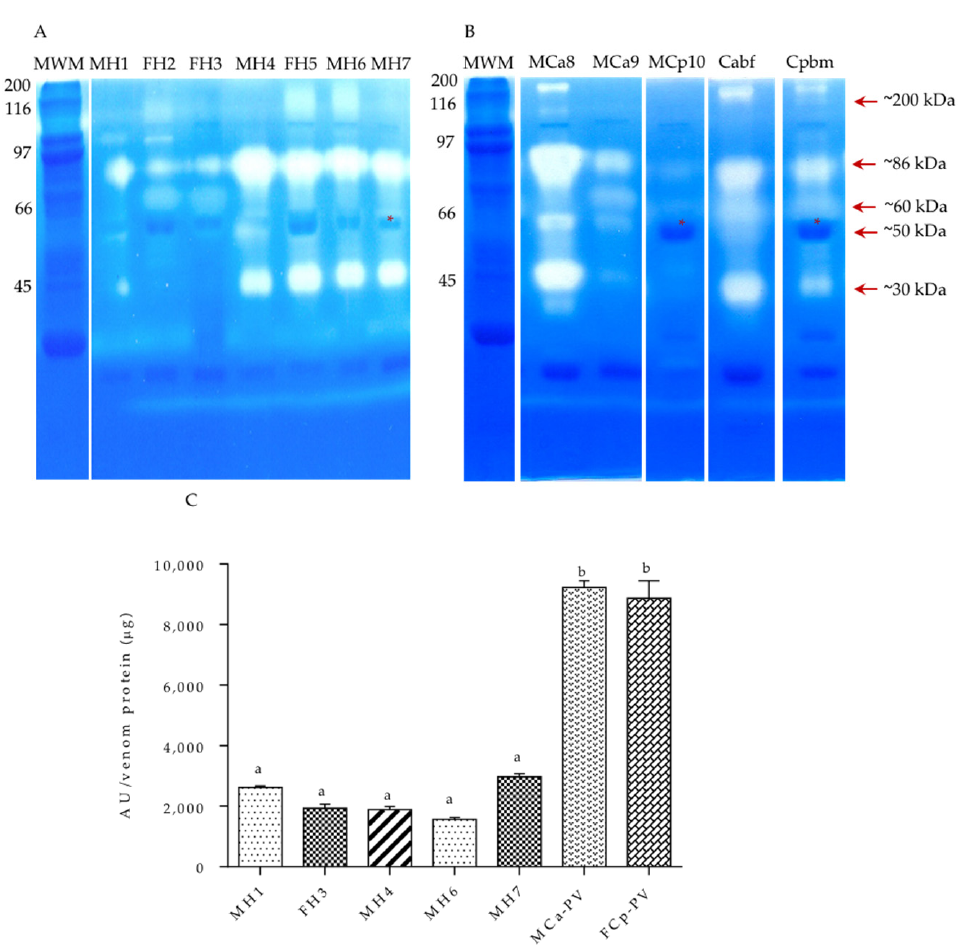
Figure 5. Venom metalloproteinase activity. ( A ) Zymography in SDS-PAGE co-polymerized with gelatin using 20 µg of protein venom under no reducing conditions. ( B ) Enzymatic activity of 100 µg of venom protein. Hybrids of the first hybridization event (four years old): MH1, MH2, FH3, and MH4; hybrids of the second hybridization event (three years old): FH5, MH6, and MH7; males of C. aquilus : MCa8, MCa9, and Cabf; organism of C. polystictus : A male, MCp10, and a female, Cpbm, used for zymography analysis. ( C ) Hybrids of the first hybridization event (11 years old): MH1, FH3, and MH4; hybrids of the second hybridization event (10 years old): MH6 and MH7; and pooled venom of venoms MCa-PV and FCp-PV were used for the determination of metalloproteinase activity. MWM, molecular weight marker. Red asterisk shows a protein shared between C. polystictus and the hybrids. Lowercase letters indicate significant statistical difference (Tukey; p < 0.05).